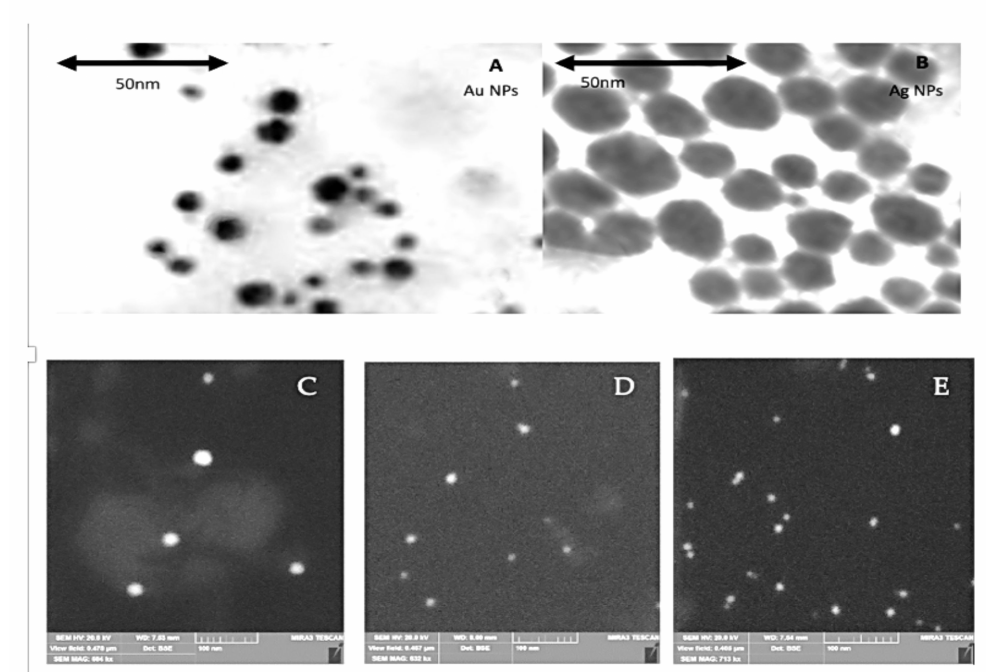
Figure 2. Electron microscopy images. Panels ( A , B ) show TEM images of Au and Ag NPs respectively. Panels ( C – E ) show SEM images of Ag, AgAu and Au NPs respectively. Panels ( C – E ) are reprinted with permission